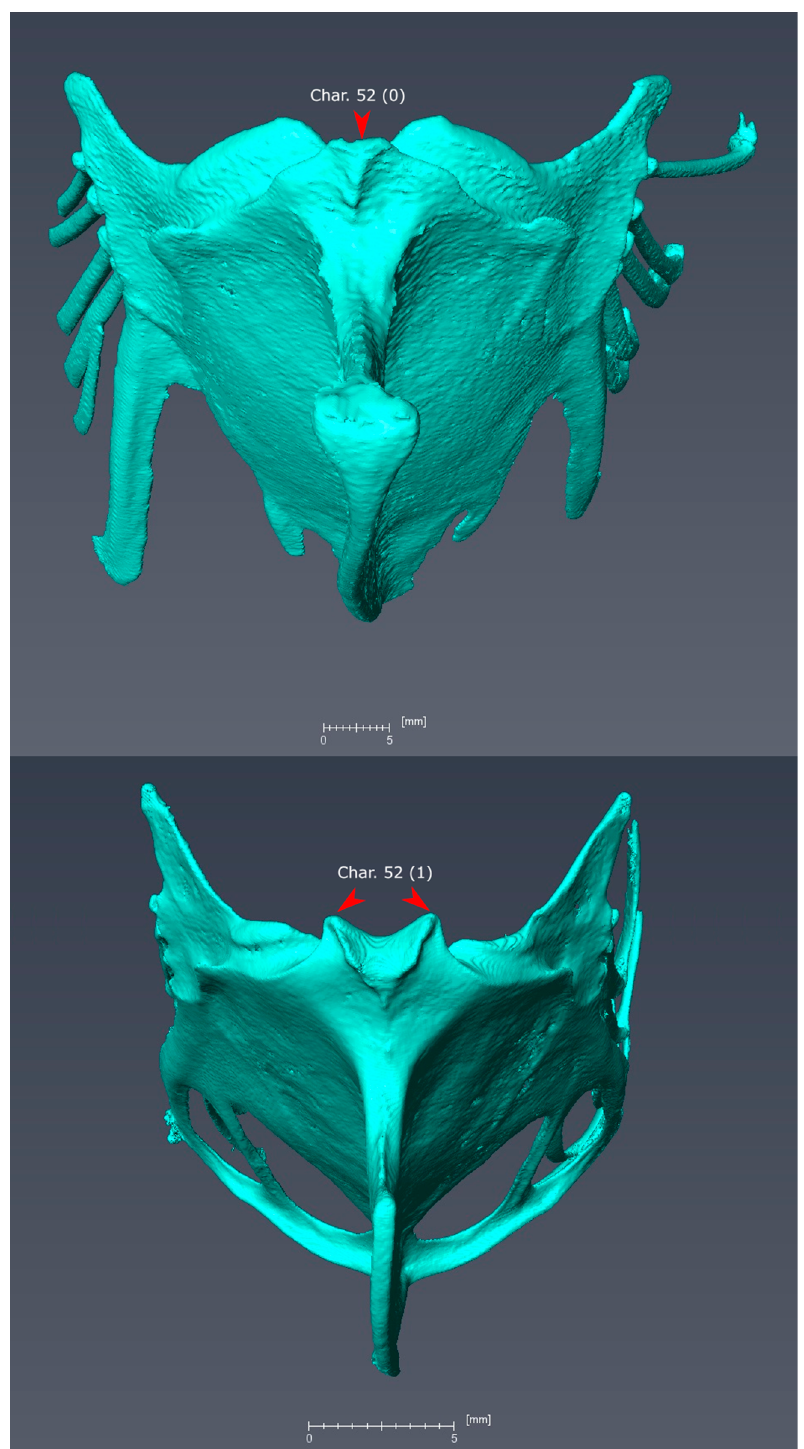
Figure A9. Sterna of Podargus strigoides (top) and Aegotheles cristatus (bottom) in cranioventral view. Podargus exhibits state 0 for character 52 (single external spine of sternum), whereas Aegotheles exhibits state 1 (bifurcated external spine of sternum, a shared feature with Hassiavis ).